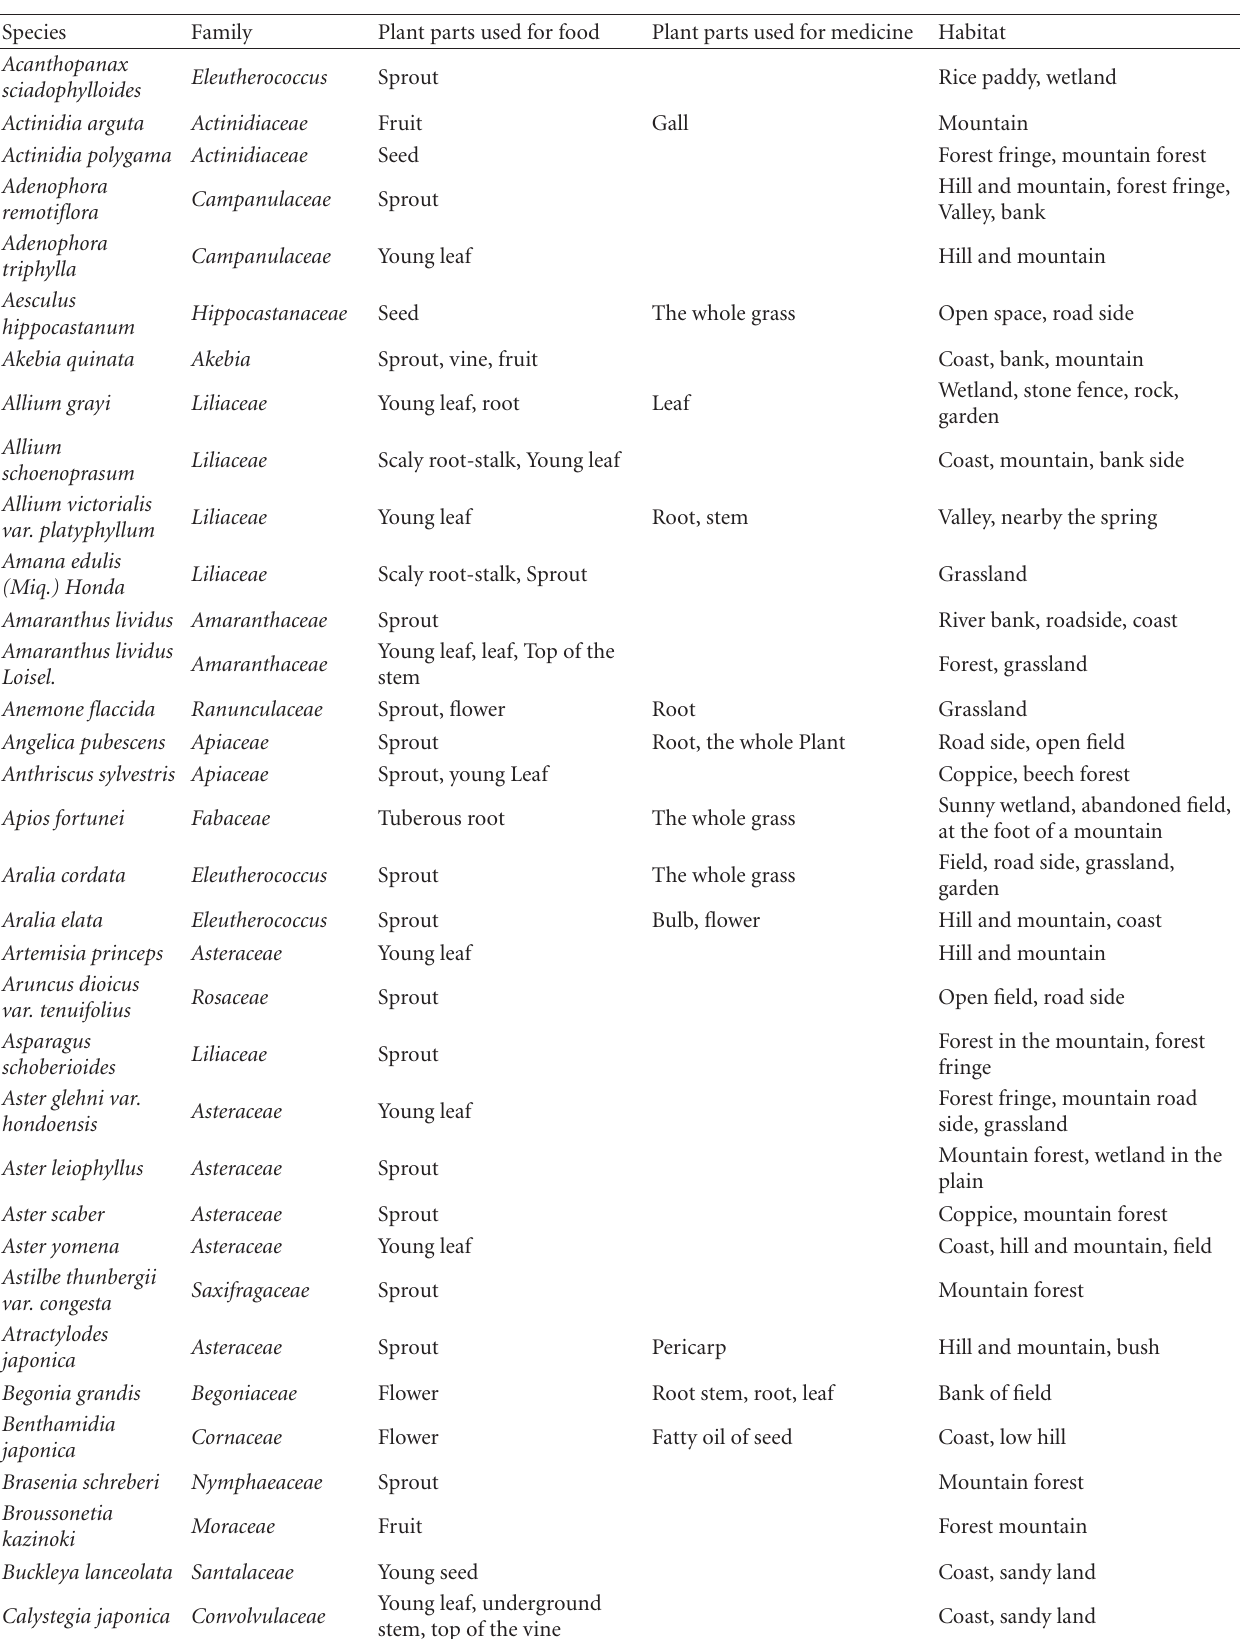
Table 1: A full list of wild plants used as food and